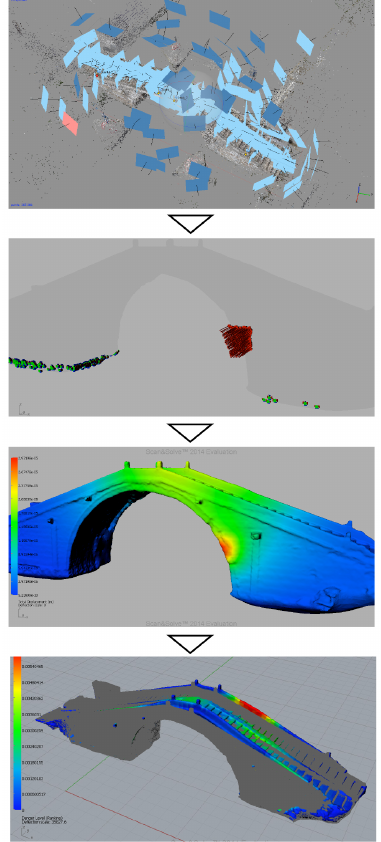
Figure 11. Workflow from image orientation to structural